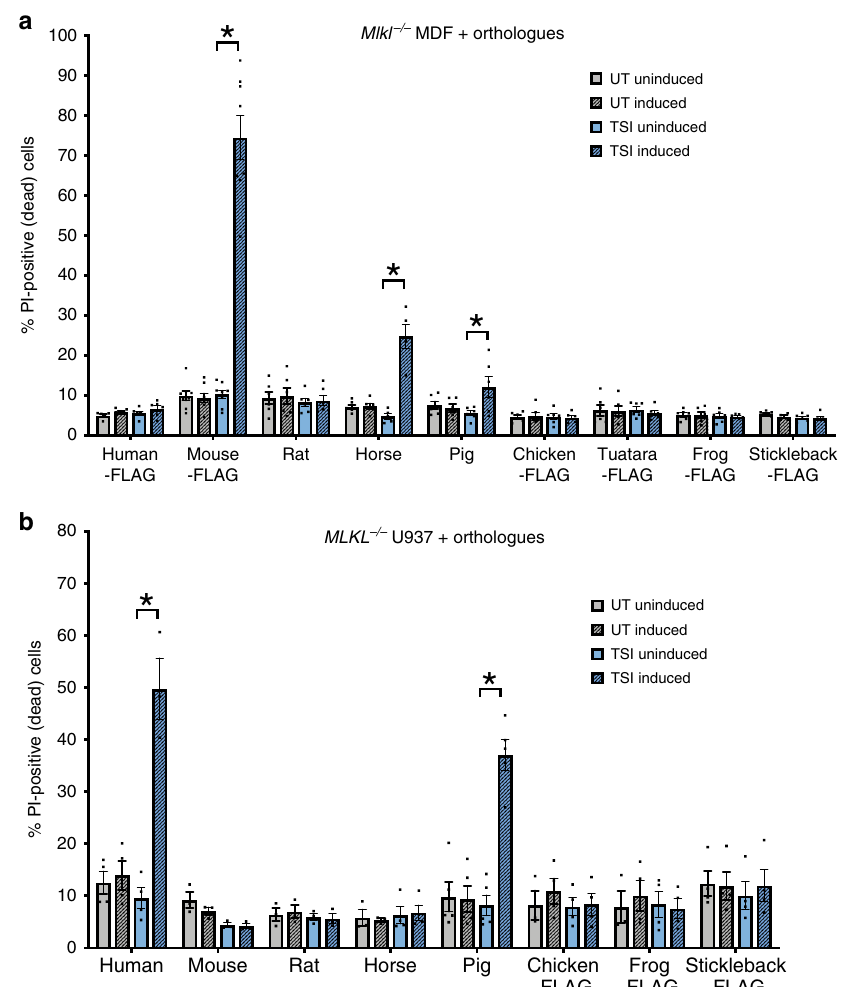
Fig. 1 Few MLKL orthologues reconstitute necroptotic signaling in mouse and human cells. Genes encoding human, mouse, rat, horse, pig, chicken, tuatara, frog and stickleback MLKL were stably introduced into Mlkl − / − mouse dermal fi broblast (MDF) ( a ) and MLKL − / − human U937 ( b ) cells